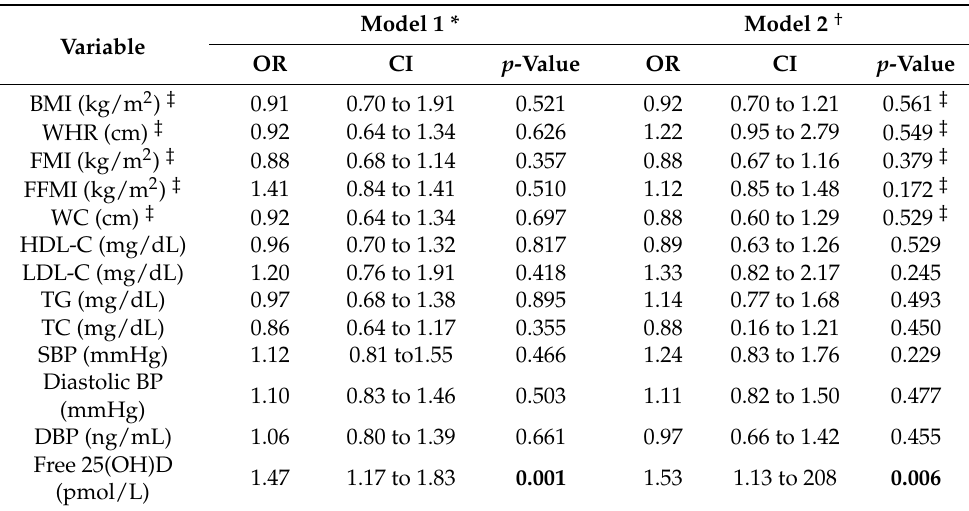
Table 3. Correlation between anthropometric measurements, lipid profile, and blood pressure with 25(OH)D.